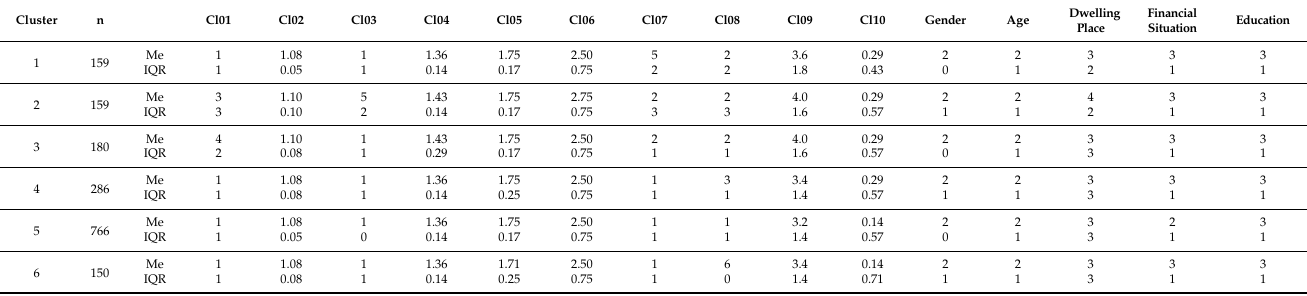
Table 5. Values of medians (Me) and quartile ranges (IQR) in the separated groups of respondents.